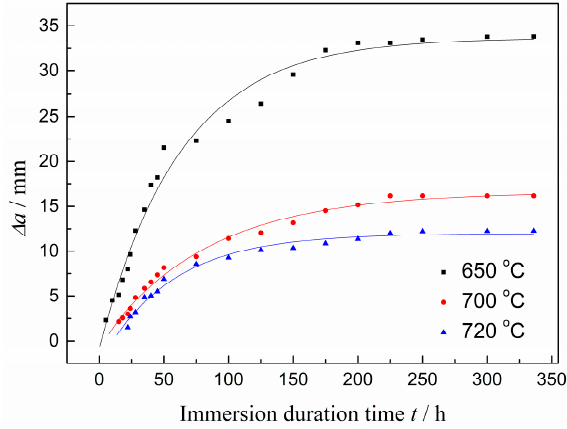
Figure 1. ∆ a as a function of immersion duration time ( t ) for Q&T–treated samples at differing T t .